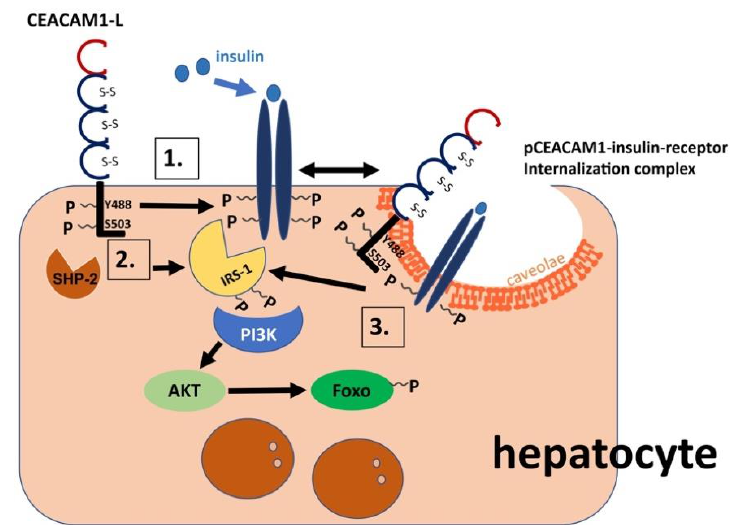
Figure 3. Regulation of insulin clearance by CEACAM1-L. (1.) Insulin binding to the insulin receptor (IR) induces its autophosphorylation and the phosphorylation of downstream substrates such as the insulin receptor substrate-1 (IRS-1) and CEACAM1-L. Phosphorylation of CEACAM1-L on Tyr488, which requires an intact Ser503 residue, mediates its indirect association with IR to increase the rate of endocytosis of the insulin-insulin receptor complex into clathrin pits/vesicles of the hepatocytes, facilitating subsequent insulin degradation and clearance. (2.) Phosphorylated CEACAM1 can bind to SHP-2 to sequester the phosphatase and subsequently, mediate more sustained phosphorylation